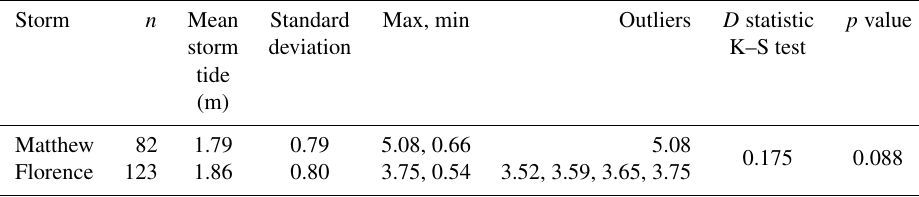
Table 1. Basic statistics on North Carolina peak storm tide during hurricanes Matthew and Florence. A measure of the difference in the distributions is given with the Kolmogorov–Smirnov D statistic. The significance level is denoted by the p value. Storm n Mean Standard Max, min Outliers p value